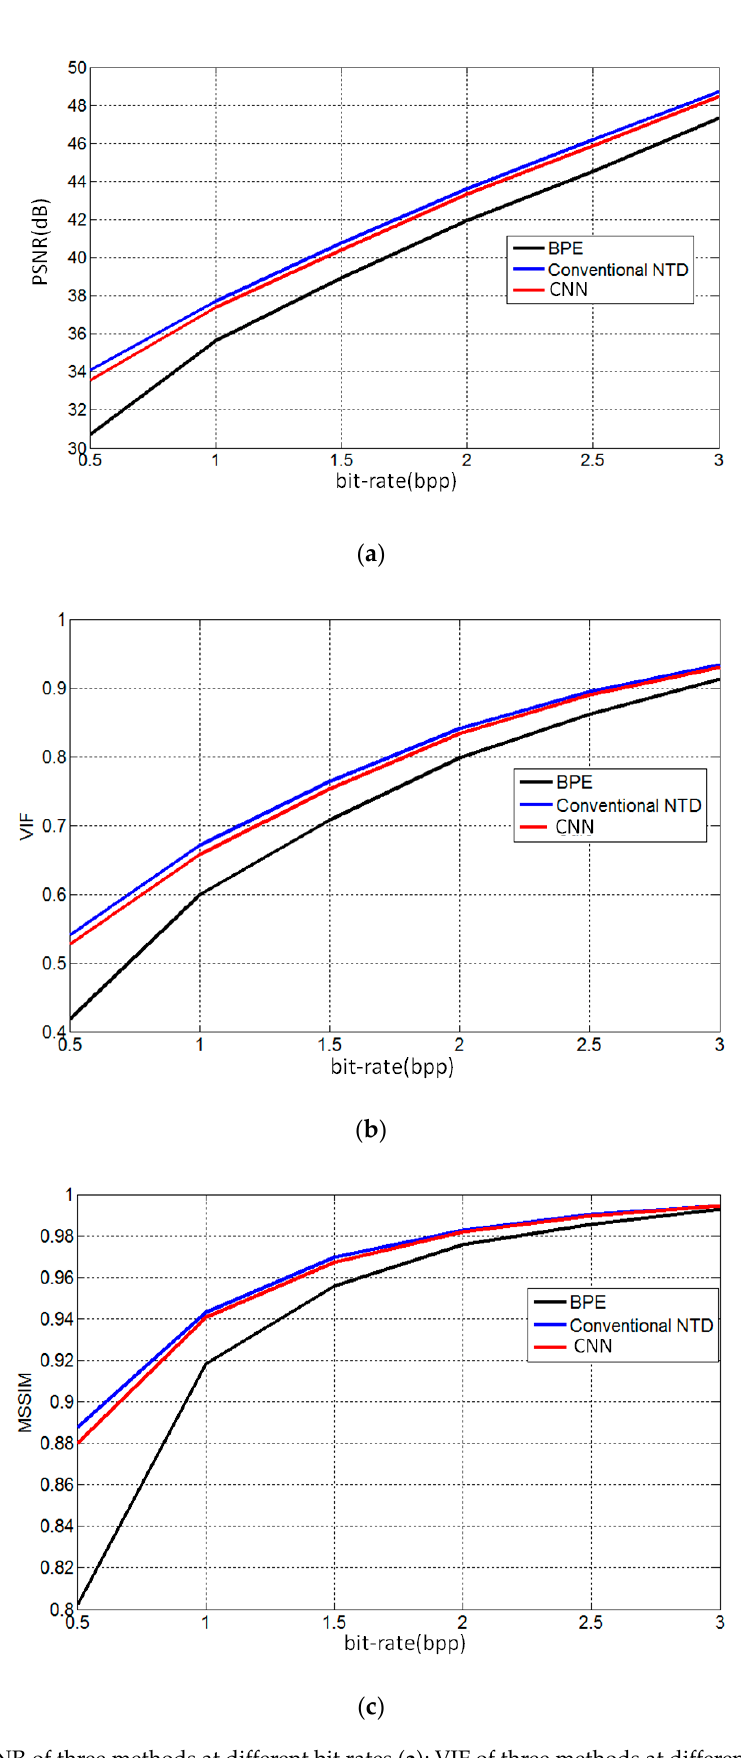
Figure 8. PSNR of three methods at different bit rates ( a ); VIF of three methods at different bit rates ( b ); and MSSIM of three methods at different bit rates ( c